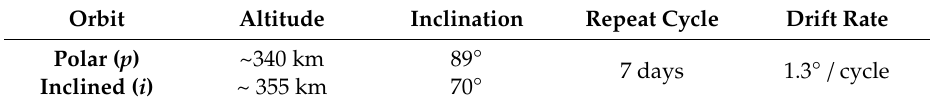
Table 1. Basic information on the simulated orbits forming the